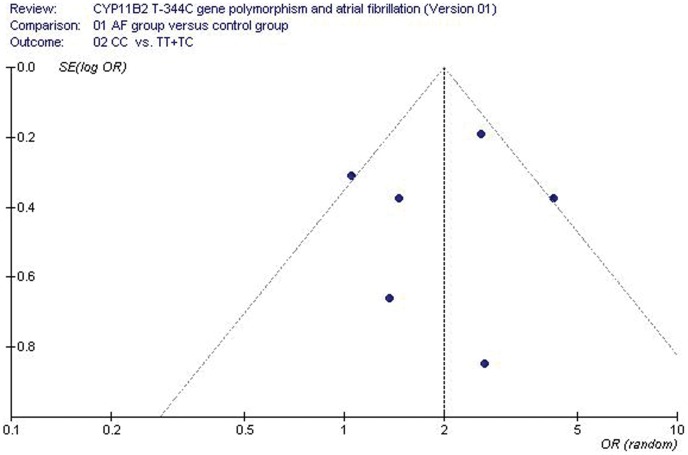
Funnel plot for studies of the association of AF associated with CYP11B2 T-344C gene polymorphism under a recessive genetic model (CC vs. TT+TC).The horizontal and vertical axis correspond to the OR and confidence limits. OR: odds ratio; SE: standard error.